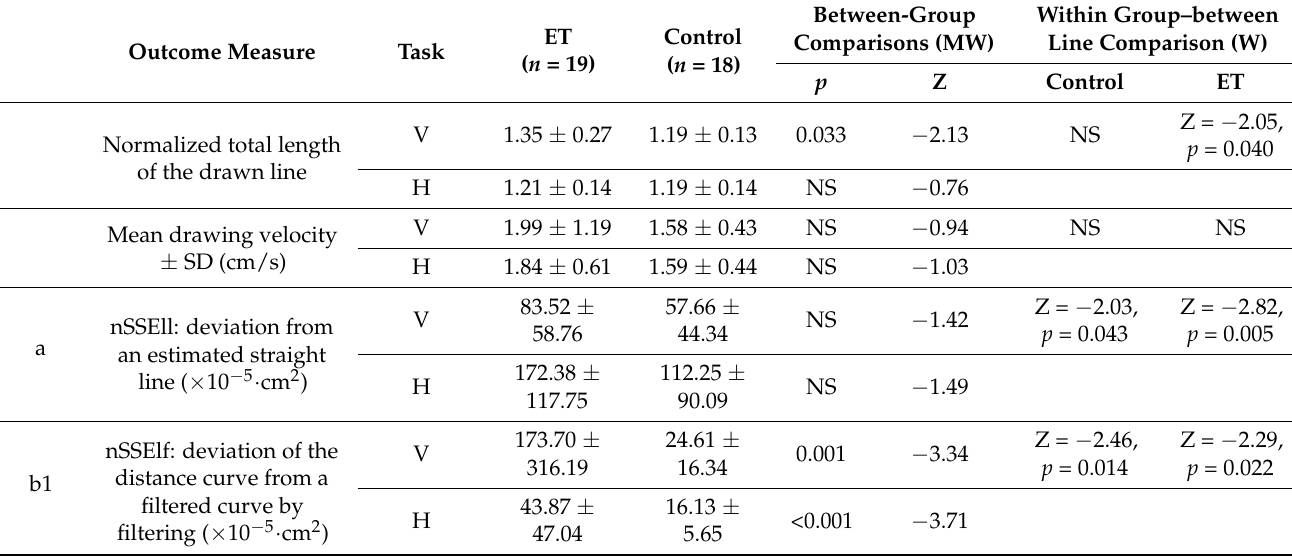
Table 3. Vertical (V) and horizontal (H) line characteristics, Mann–Whitney sensitivity between groups (Z, p ), and Wilcoxon analysis within group results for comparing vertical and horizontal line tasks.